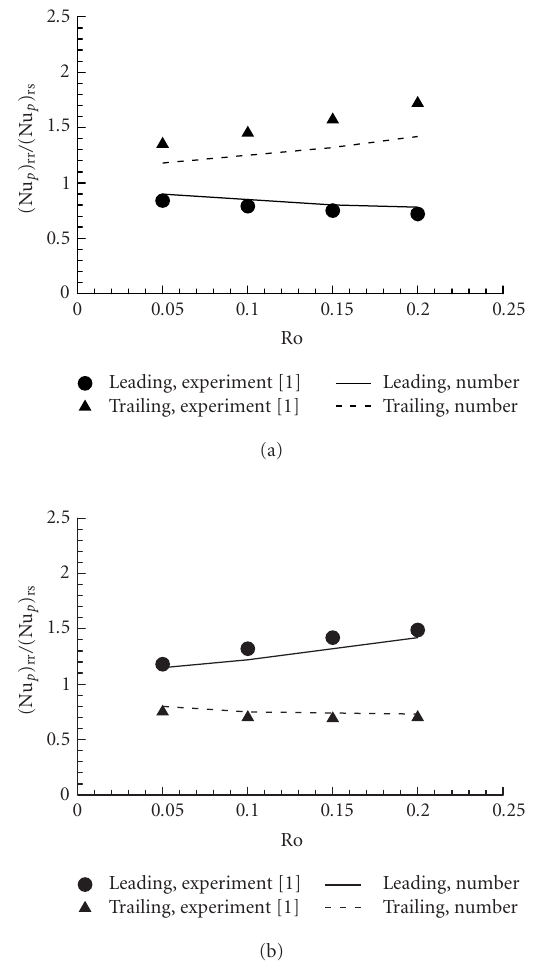
Figure 8: Comparison between presently computed and previously measured passage-averaged Nusselt number ratio versus rotation number in (a) first pass and (b) second